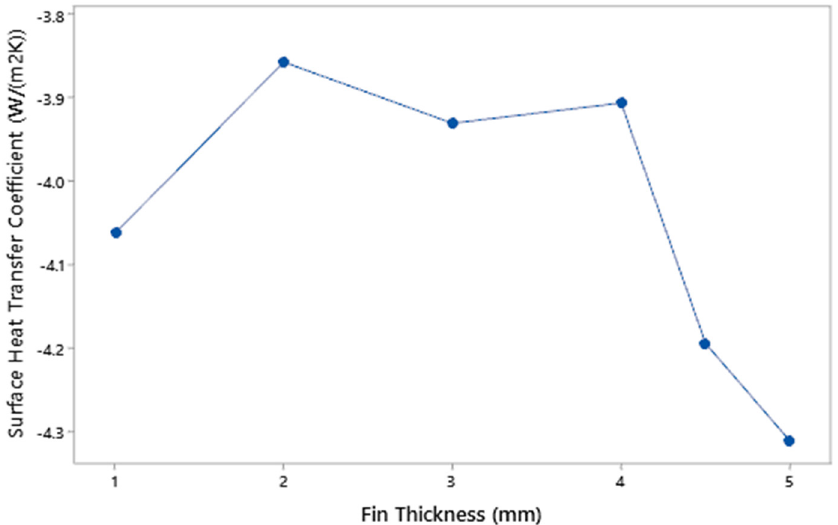
Figure 15. Plot of Heat Transfer Coefficient vs fin thickness (mm) .